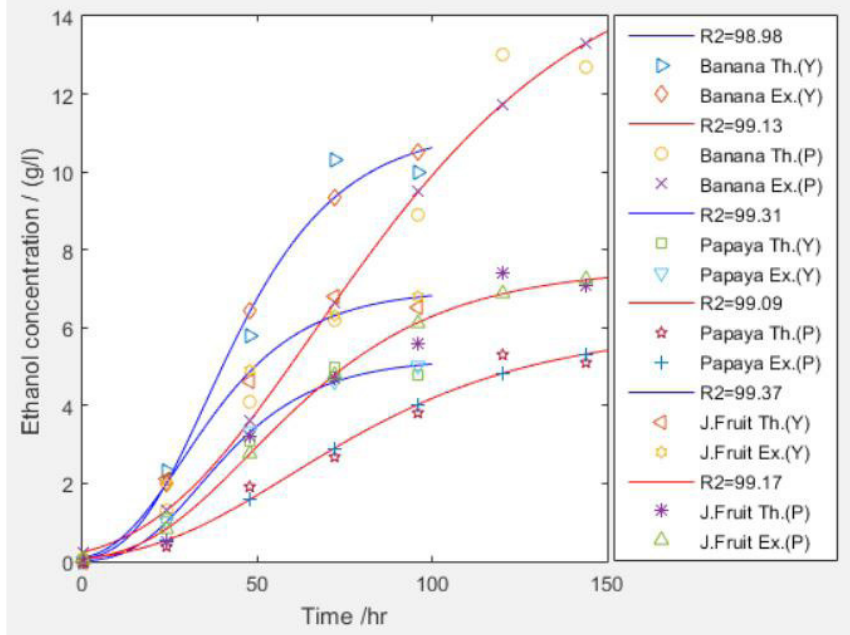
Figure 1: Variation of sugar concentration in the filtrate with time (considering the highest correlation of each fruit variety and each microorganism).